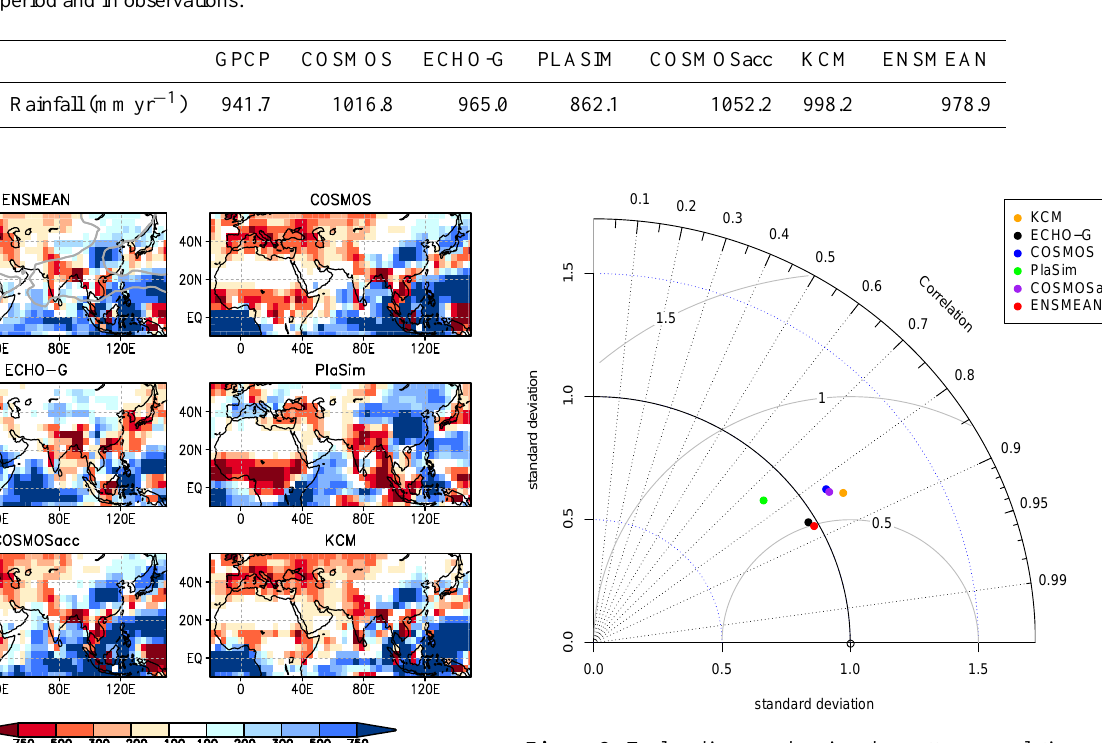
Figure 3. Taylor diagram showing the pattern correlation, nor- malised standard deviation and normalised root-mean-square error (grey circles) of the simulated precipitation in the different models (0k-time-slice) for the Afro-Asian monsoon region. Reference data set: GPCP, based on the years 1979–2008 (white